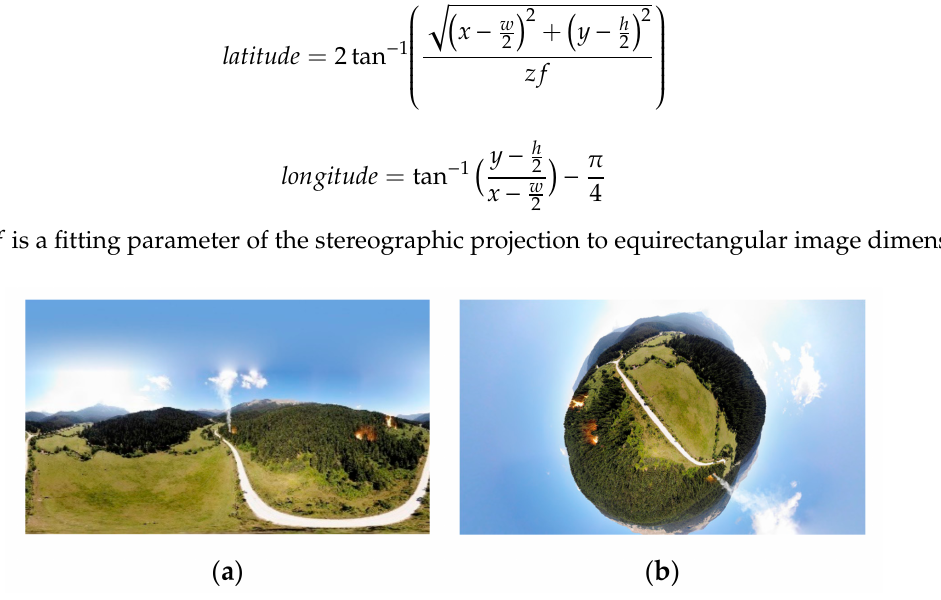
Figure 3. Projections of 360-degree images: ( a ) equirectangular, ( b ) stereographic